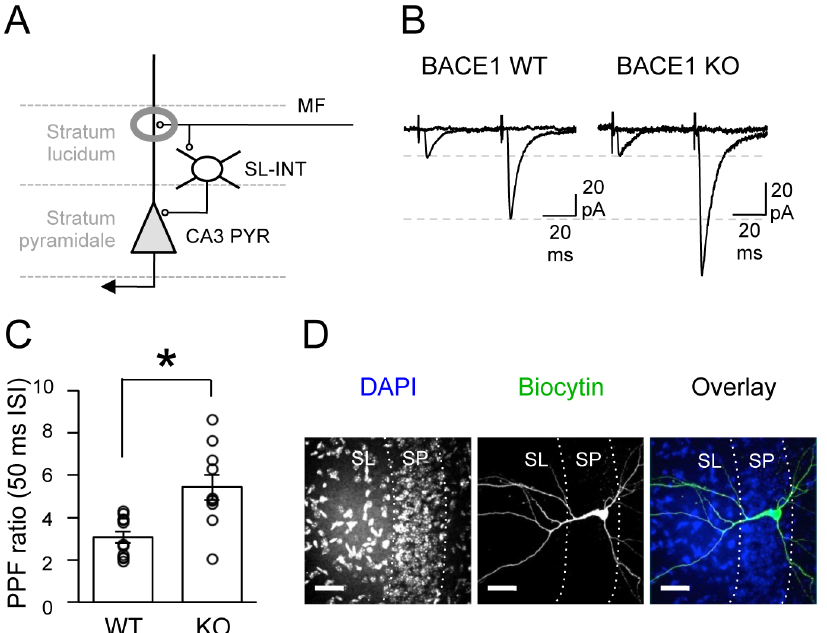
Figure 2. Increased paired-pulse facilitation of eEPSCs at MF inputs to CA3 PYRs in BACE1 KOs. (A) A diagram showing the CA3 circuitry. Mossy fibers (MF) form glutamatergic excitatory synapses onto CA3 pyramidal cells (PYRs) as well as onto inhibitory SL-INTs in the stratum lucidum; SL-INTs project GABAergic synapses onto CA3 PYRs. The grey circle highlights the monosynaptic excitatory synapses of MF terminals onto CA3 PYRs. (B) Representative evoked EPSC traces from CA3 PYR following paired-pulse stimulation at 50 msec ISI before and after DCG-IV application in WTs and KOs. (C) PPF ratio was significantly increased in BACE1 KOs at 50 msec ISI compared to WTs. PPF ratio of individual cells are overlayed on the bar graph as open circles. *t-test: P , 0.01. (D) Immunohistochemical labeling of a representative biocytin filled CA3 PYR. Left: DAPI staining of the CA3 subfield where a biocytin filled pyramidal cell was located. Stratum pyramidale (SP) and stratum lucidum (SL) borders are marked as white dotted lines. Middle: Biocytin staining of a recorded CA3 PYR. Right: Overlay of DAPI (blue) and biocytin (green). Scale: 40 m m.